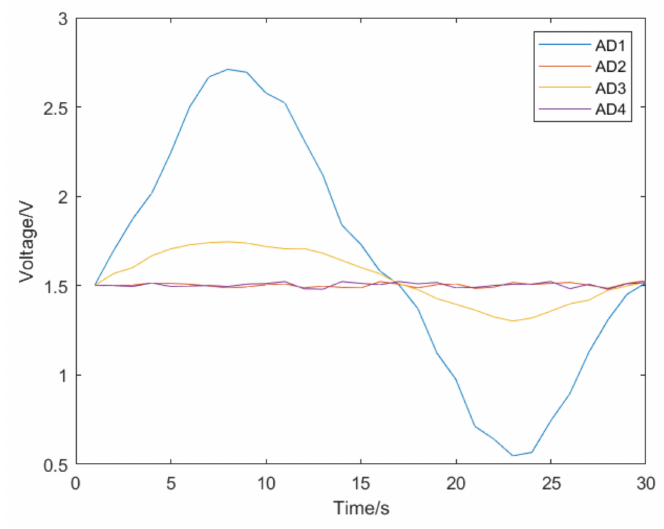
Figure 12. The voltage change of the strain gauges during a catheter